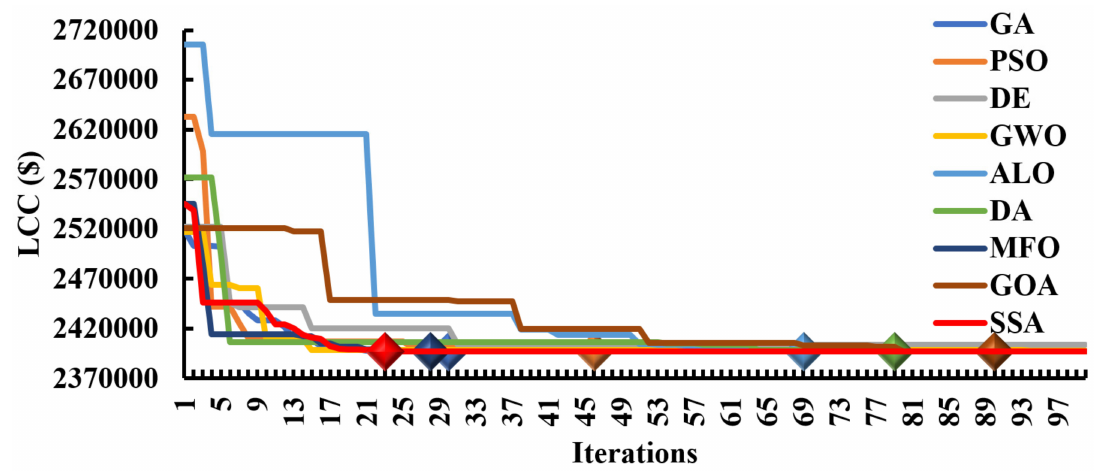
Figure 20. Convergence curves of Li-Ion at 50% DOD with